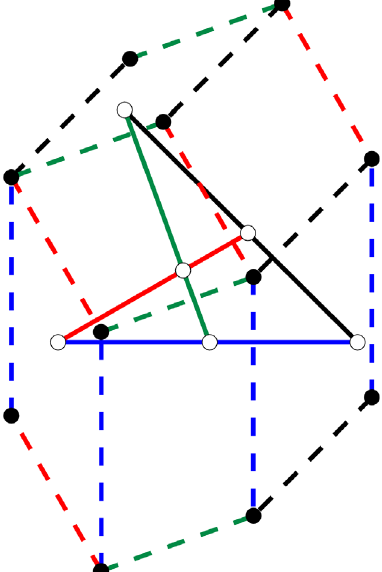
FIG. 6. The quasireciprocal relation between a finite parallelo- gram tiling and a finite fiber network ( N F ¼ 4 ). Corresponding edges are shown in the same color (solid for the fiber network and dashed for the parallelogram tiling). In this figure, V F 6 ; E 8 ; E 16 , so the number of fiber ¼ tiling ¼ fiber ¼ tiling ¼ FMs in the parallelogram tiling is N m ¼ 3 ¼ N F − 1